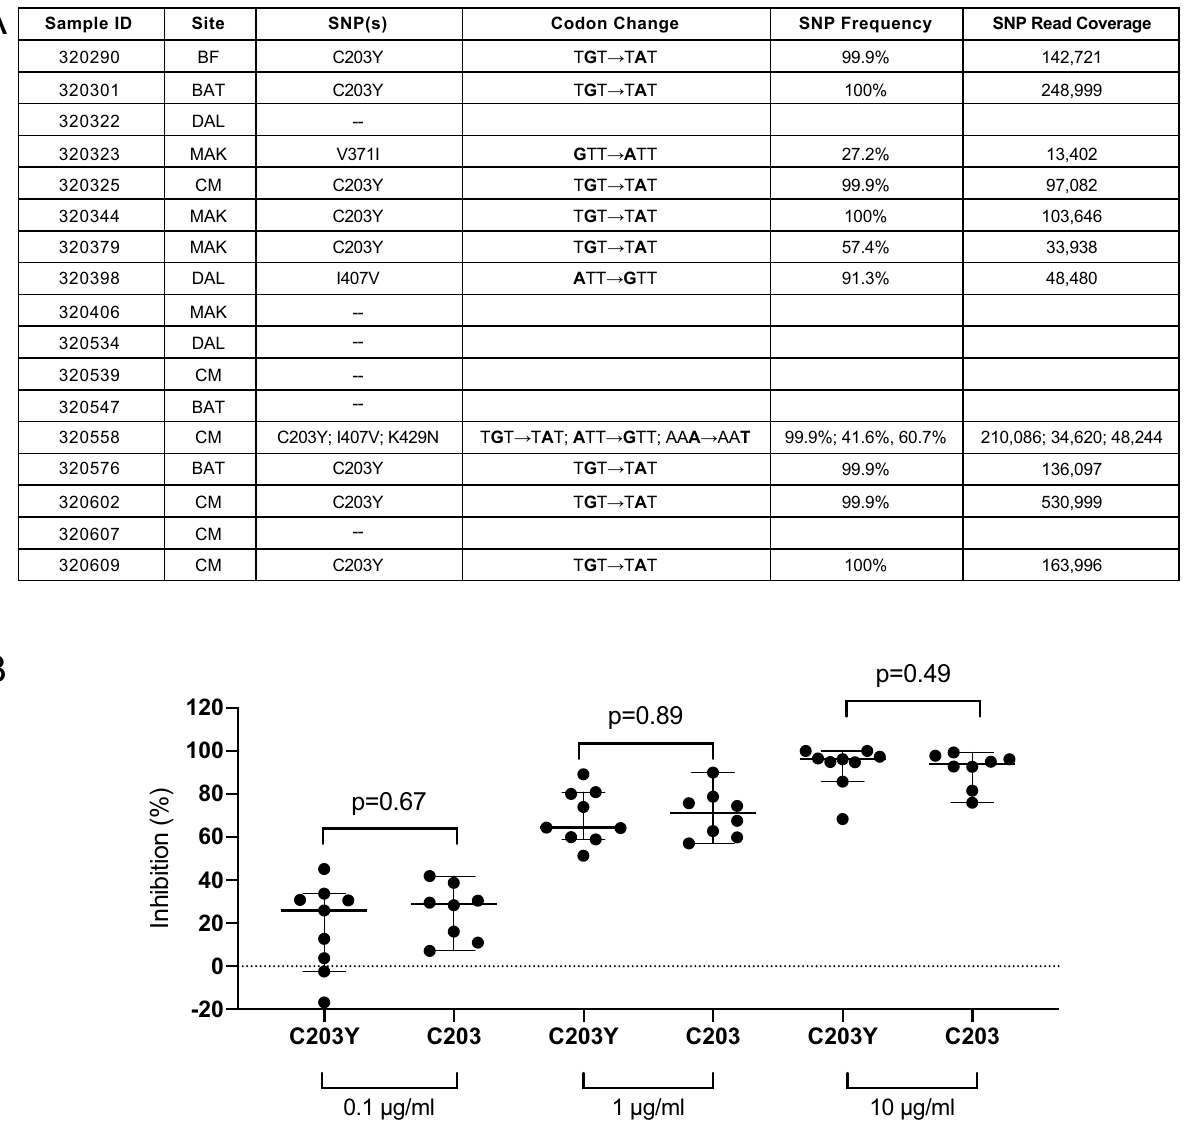
Figure 2. Genotype–phenotype associations identified that dominant SNPs in PfRh5 do not influence invasion inhibition. Next Generation Sequencing (NGS) analysis of samples from successful ex vivo invasion assays. ( A ) Description of the single nucleotide polymorphisms (SNPs) identified in patient samples from Kédougou. Specific site of collection is abbreviated as follows: Bandafassi (BF), Bantaco (BAT), Camp Militaire (CM), Dalaba (DAL), Mako (MAK). Both nucleotide and corresponding nonsynonymous amino acid changes are indicated. SNP frequency and read coverage at the SNP site (SNP Read Coverage) are also indicated. Sequences are accessible in Genbank (MW042085-MW042101). Of the 11 samples with SNPs at the dominant threshold (25%), 9 (52.9%) contained the C203Y SNP, 2 (11.8%) contained I407V, 1 (5.9%) contained K429N, 1 (5.9%) contained V371I. Sample 320558 is the only one to contain more than one SNP. Six samples contained no SNPs. These SNPs have been previously described in both published 9,11,13,19,20 and unpublished data generated by the Pf3k project (www.malar iagen .net/pf3k), representing 3,248 samples from 40 separate locations in 20 countries 9 . ( B ) Genotype–phenotype associations were performed for samples with the C203Y SNP and those without (C203Y vs C203 respectively), at each concentration of anti-BSG (MEM-M6/6) antibody. Medians and 95% confidence intervals are shown. No statistically significant difference between either genotype was observed at any of the antibody concentrations